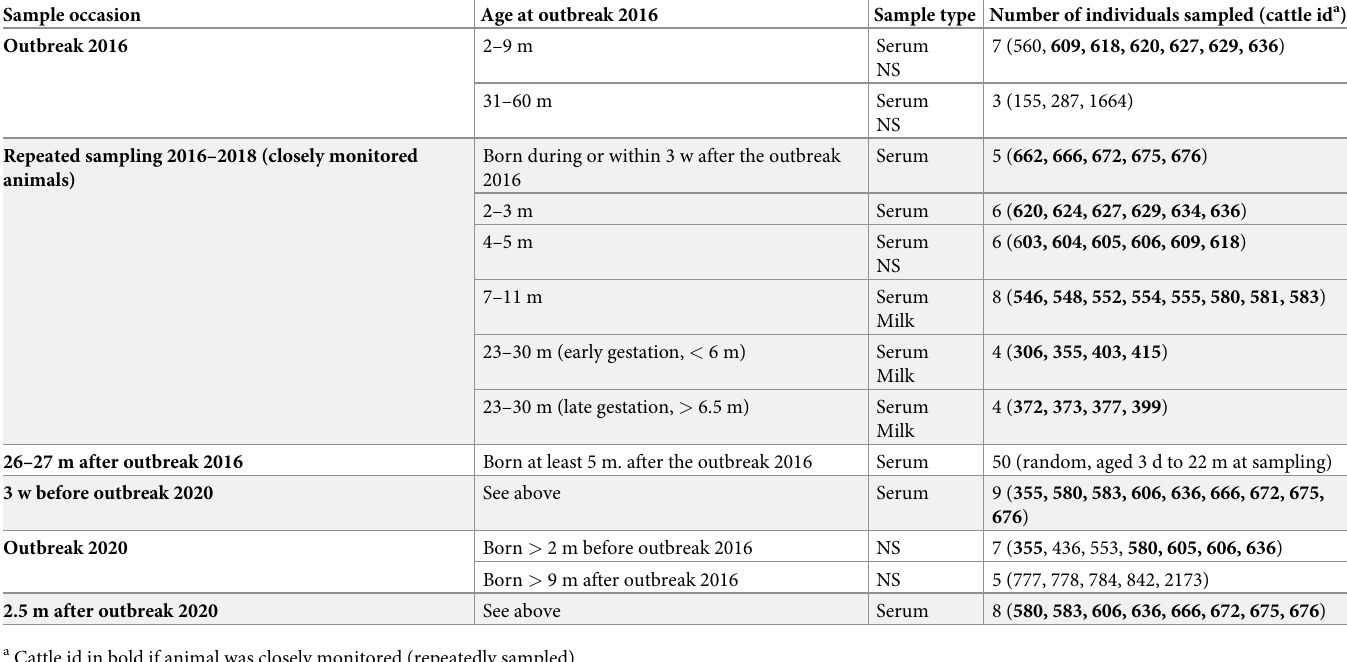
Table 2. Sampling for BRSV diagnosis and monitoring of BRSV-specific immunity. Sample